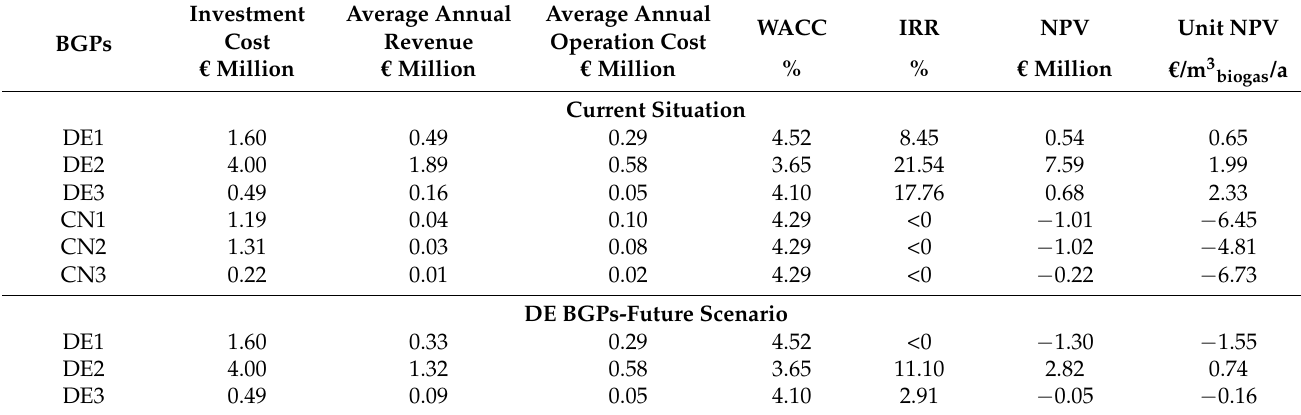
Table 5. Estimated financial indicators for German (DE) and Chinese (CN) biogas plants (BGPs).